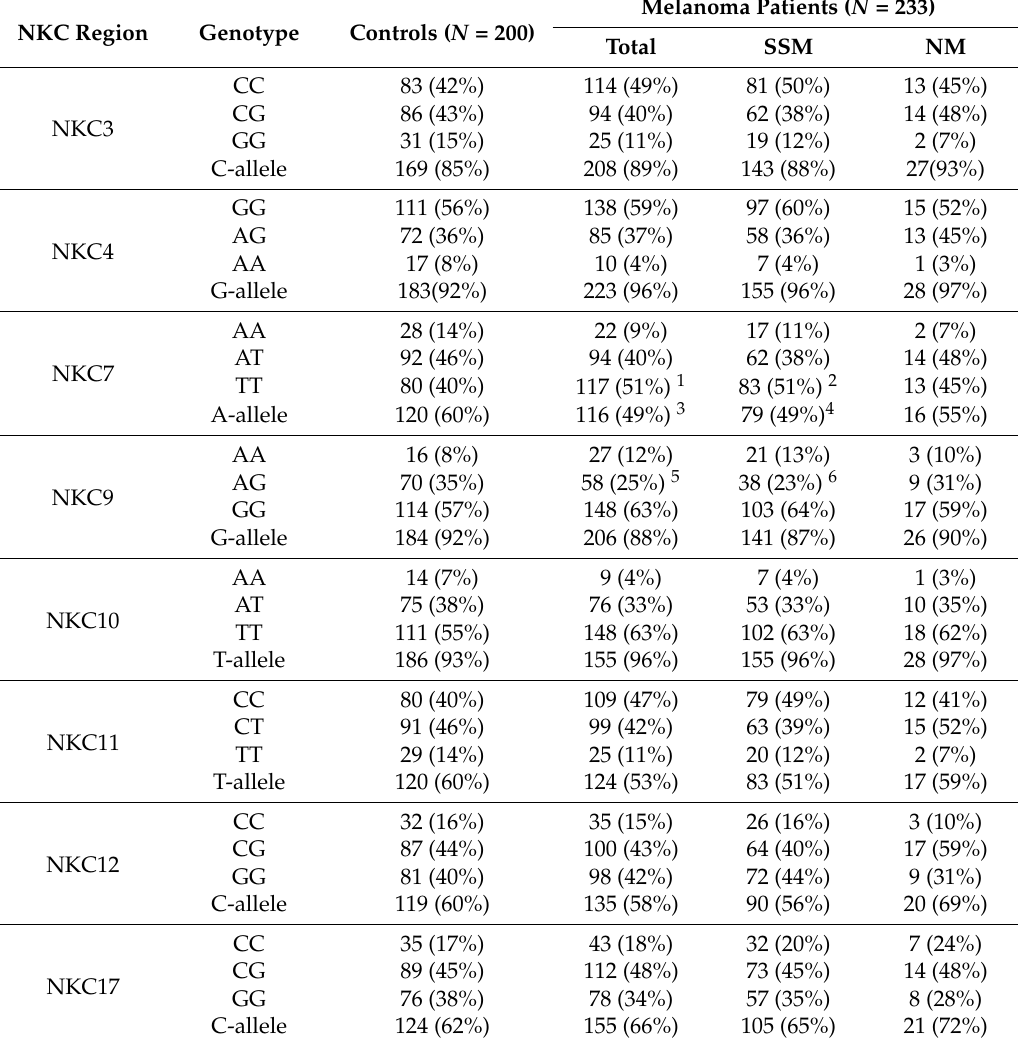
Table 2. NKC allele and genotype frequencies in healthy controls and melanoma